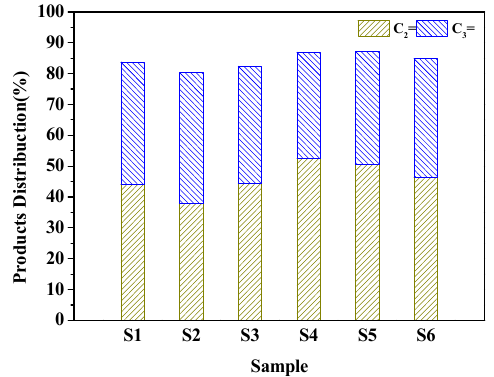
Figure 9. The product distribution of the MTO reaction on SAPO-34 samples at 723 K and a WHSV of 3 h − 1 .